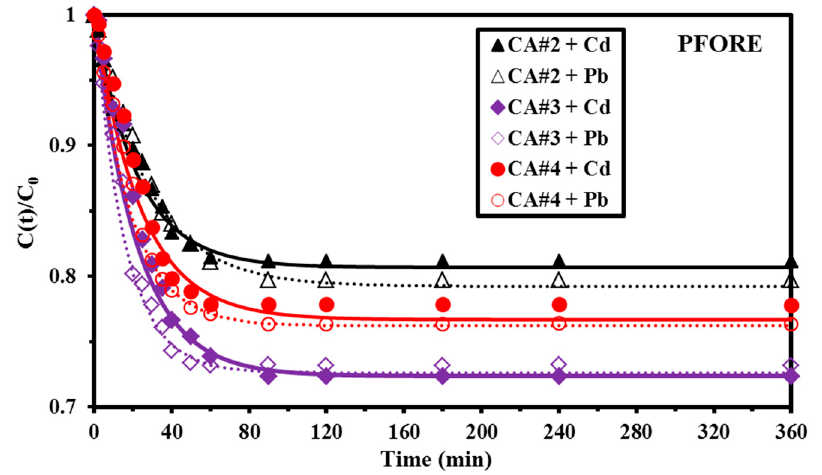
Figure 4. Sorption kinetics profile of the pseudo-first (PFORE) for Cd (dark symbols/solid lines) and Pb (dark symbols/dotted lines) (C 0 : 100 (±5) mg L − 1 ; SD: 250 mg L − 1 , pH 0 : 5). Table 1. Parameters of the kinetic models for Cd(II) and Pb(II) of using CA#2–4. C 0 : (mmol M L − 1 )